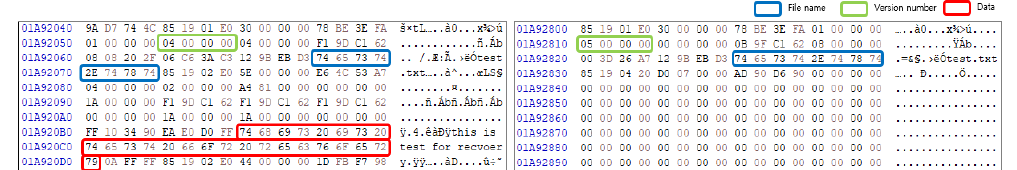
Figure 25. Recovery of deleted files in JFFS2 by verifying file versions.